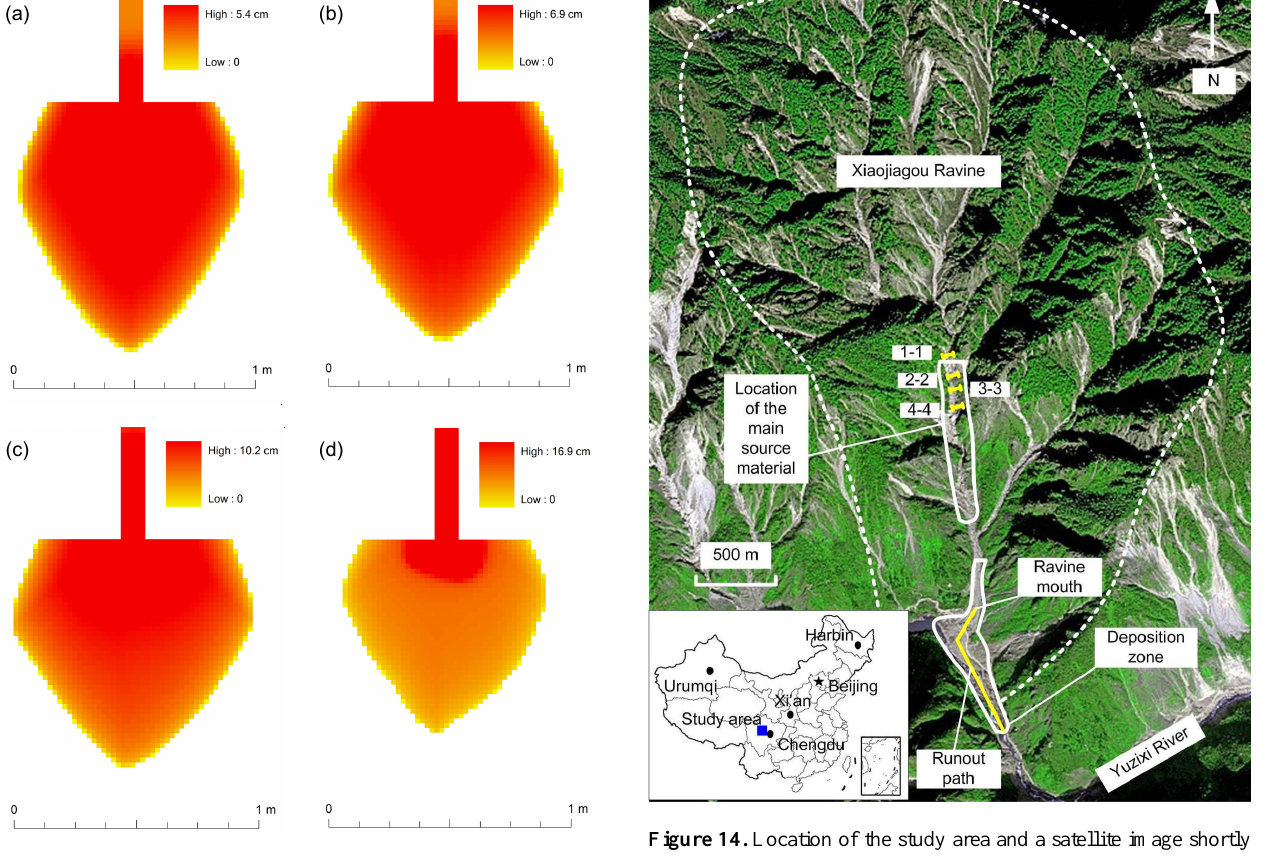
Figure 13. Debris fans at final stage considering different coeffi- cients of deposition rate: (a) δ d is 0.03, (b) δ d is 0.05, (c) δ d is 0.1, (d) δ d is 0.5.